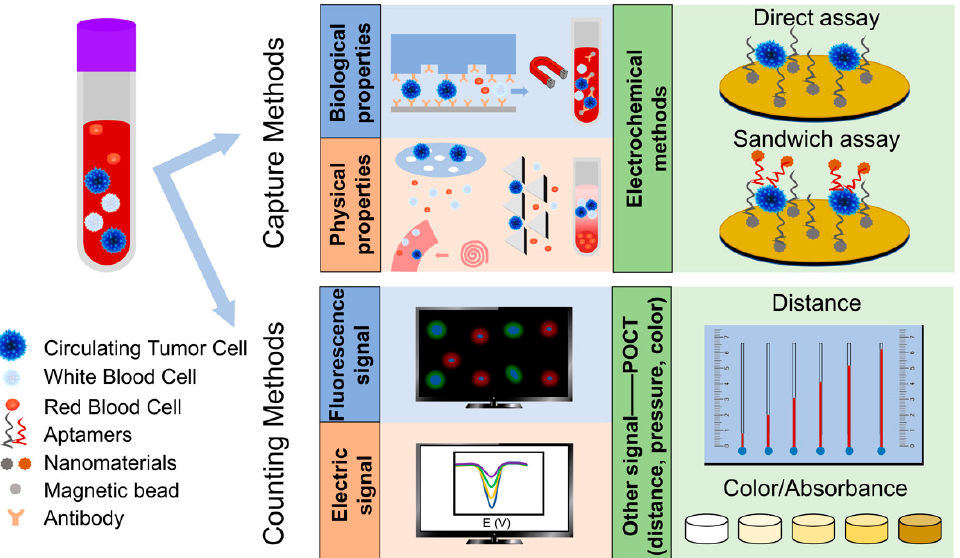
Figure 2. The capture methods and counting methods of CTC. The capture methods including biological properties-based methods, physical properties-based methods and electrochemical methods. The counting methods including fluorescence signal-based methods, electric signal-based methods and other signal-based methods (simple signal, such as distance, pressure and color etc.).